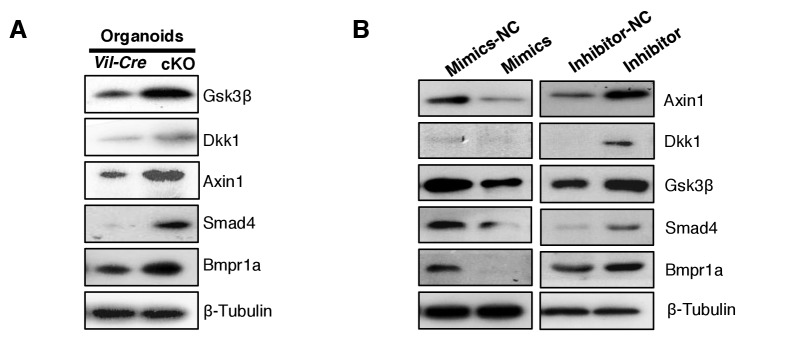
Identification of miR-31 target genes.(A) Western blotting for Gsk3β, Dkk1, Axin1, Smad4 and Bmpr1a in cultured organoids from Vil-Cre and miR-31 cKO crypts. n = 4 technical replicates. β-Tubulin was used as a loading control. (B) Western blotting for Dkk1, Axin1, Gsk3β, Smad4 and Bmpr1a in HCT116 cells under treatment of control (mimics-NC) and miR-31 mimics, or control (inhibitor-NC) and anti-miR-31. β-Tubulin was used as a loading control, which is identical to Figure 4—figure supplement 1C and Figure 5—figure supplement 1D.